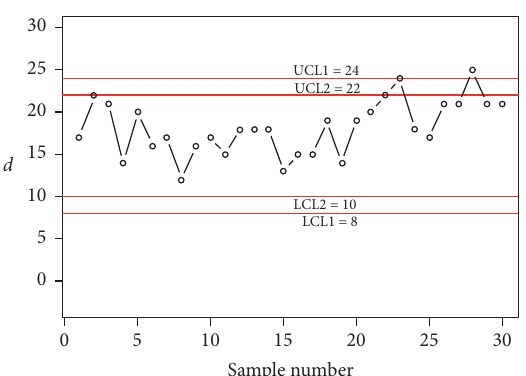
Figure 2: The Birnbaum–Saunders chart based on the RS method for simulated